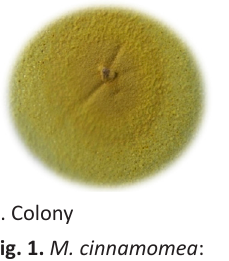
Fig. 1. M. cinnamomea